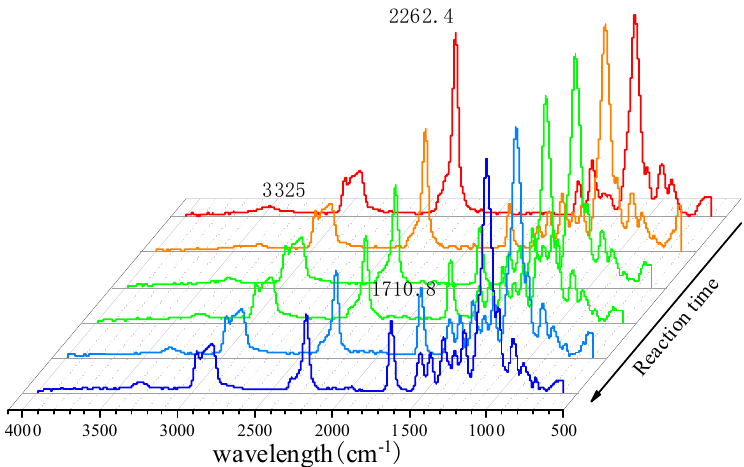
Figure 4. FT-IR spectra of real-time detection of polyurethane prepolymer.